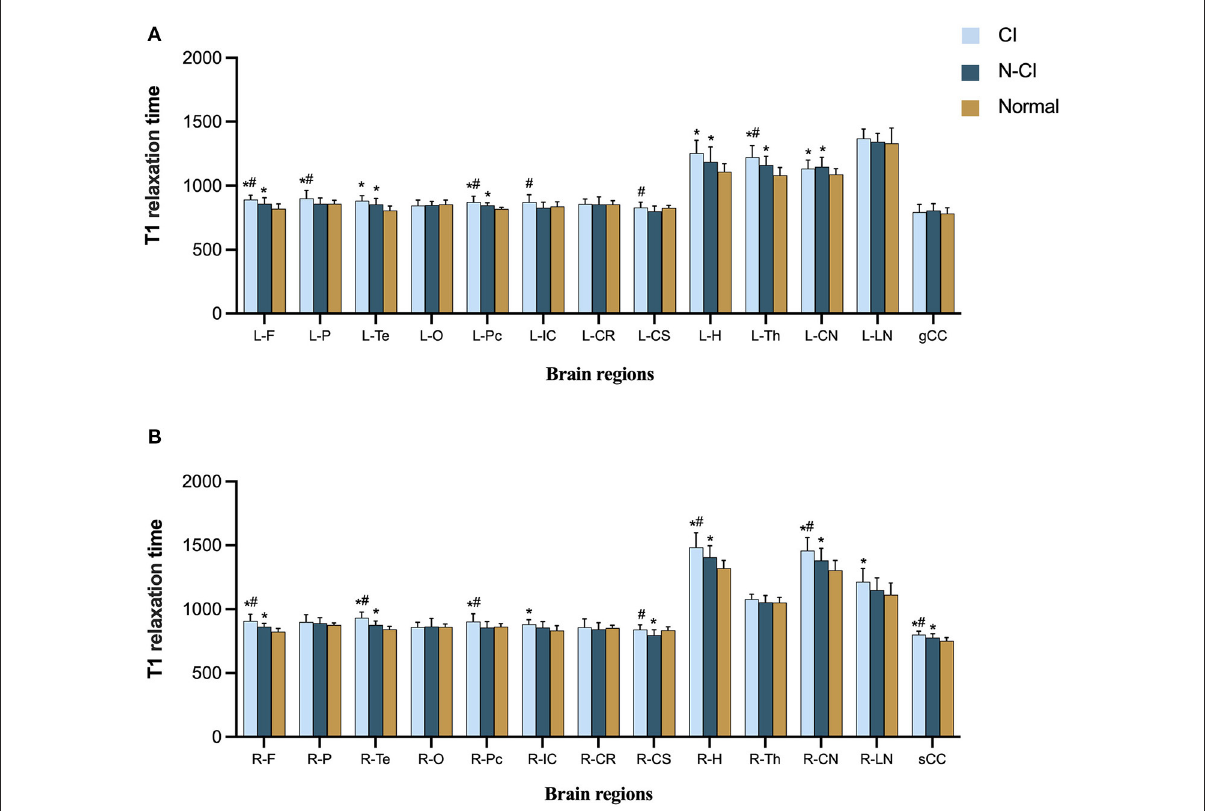
FIGURE1 Means ( ± SD) of T1 relaxation times in each ROI, for each study group. (A) Left hemisphere and genu of corpus callosum; (B) right hemisphere and splenium of corpus callosum. CI patients had significantly higher T1 relaxation times in most ROIs than the N-CI and Normal groups. ROIs: L-F, left frontal lobe; L-P, left parietal lobe; L-Te, left temporal lobe; L-O, left occipital lobe; L-Pc, left precuneu; L-IC, left internal capsule; L-CR, left corona radiata; L-CS, left centrum semiovale; L-H, left hippocampus; L-Th, left thalamus; L-CN, left corona radiata; L-LN, left lentiform nucleus; R-F, right frontal lobe; R-P, right parietal lobe; R-Te, right temporal lobe; R-O, right occipital lobe; R-Pc, right precuneu; R-IC, right internal capsule; R-CR, right corona radiata; R-CS, right centrum semiovale; R-H, right hippocampus; R-Th, right thalamus; R-CN, right corona radiata; R-LN, right lentiform nucleus; gCC, genu of corpus callosum; sCC, splenium of corpus callosum.* p < 0.05 vs. Normal group, # p < 0.05 vs. N-CI group.